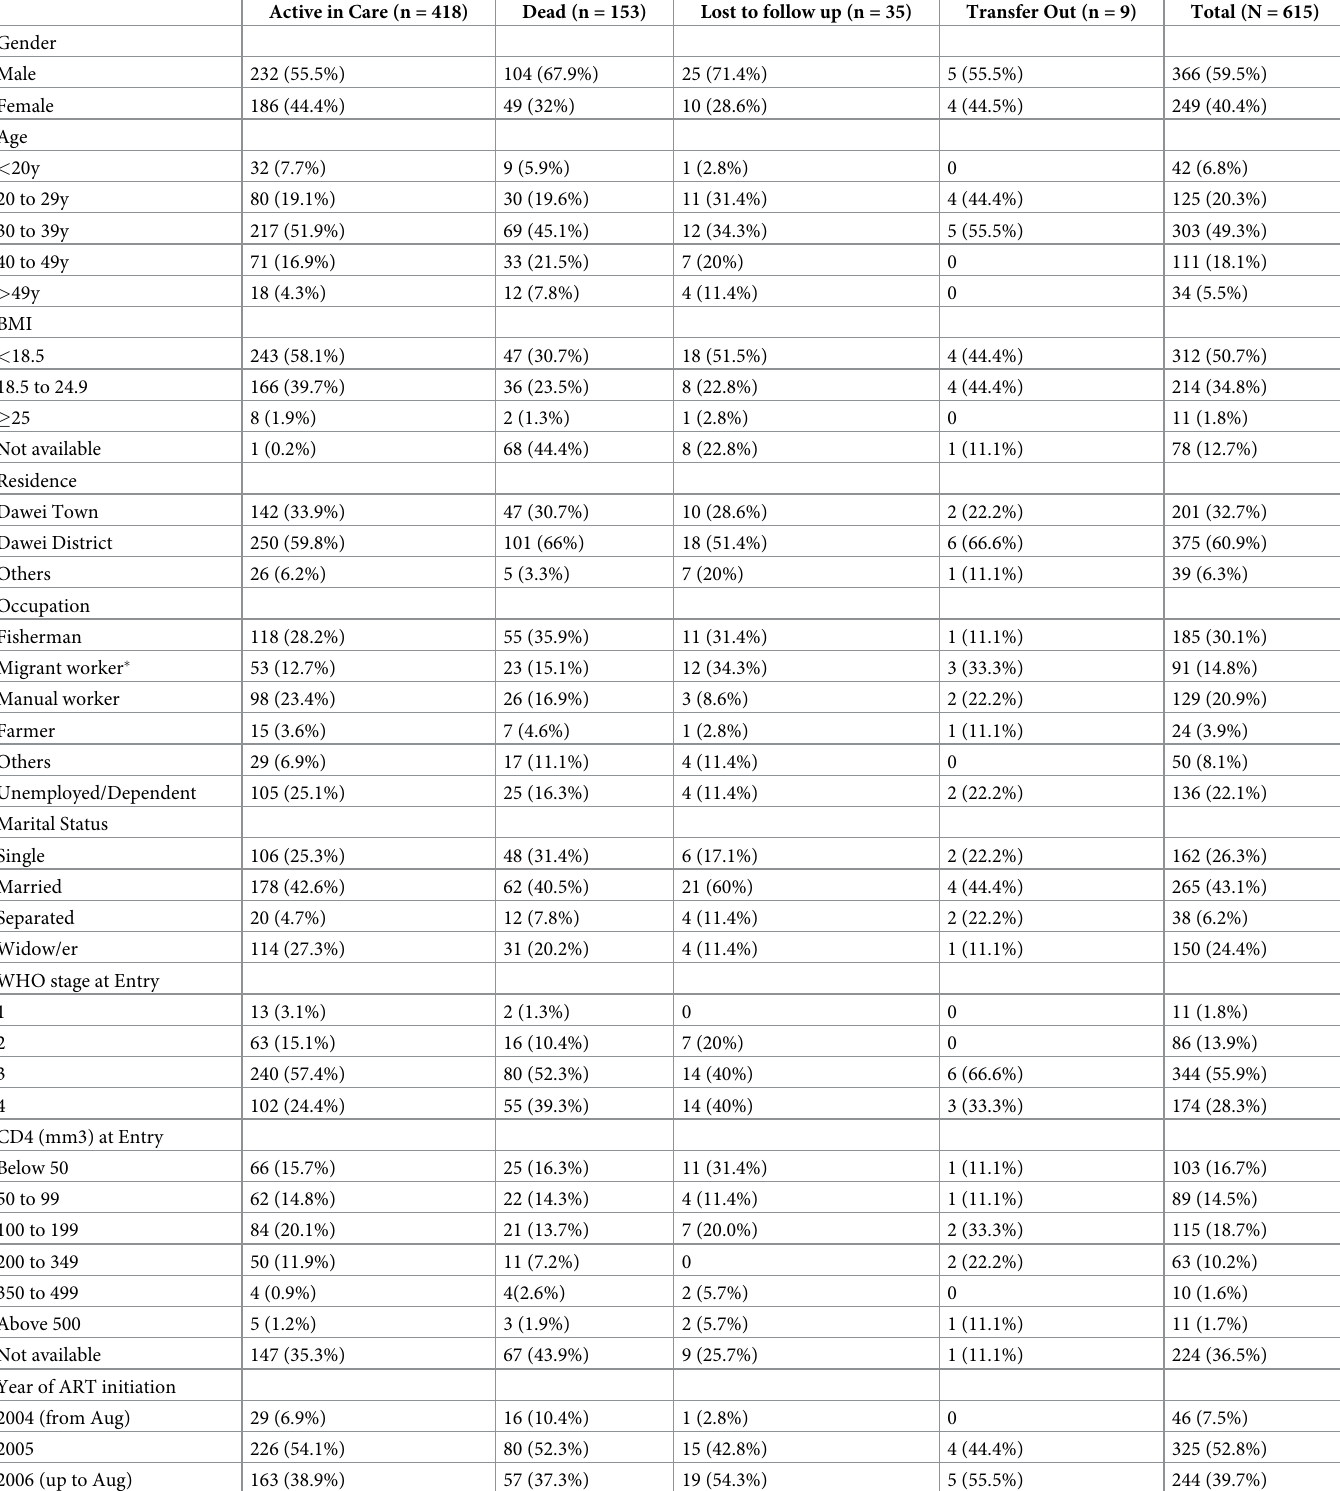
Table 1. Baseline characteristics of patients initiating treatment in 2004–2006 stratified by treatment outcomes, Dawei